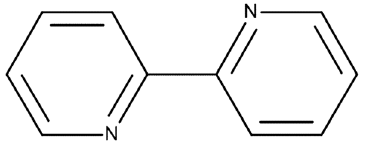
Figure 1 Structure of the 2,2′-bipyridine